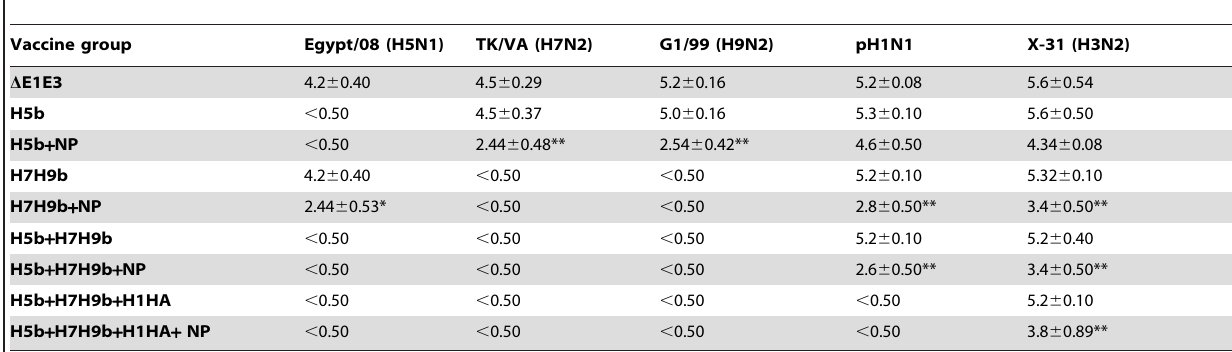
Table 4. Virus lung titers in vaccinated mice challenged with influenza viruses from H5, H7, H9, H1 and H3 subtypes.